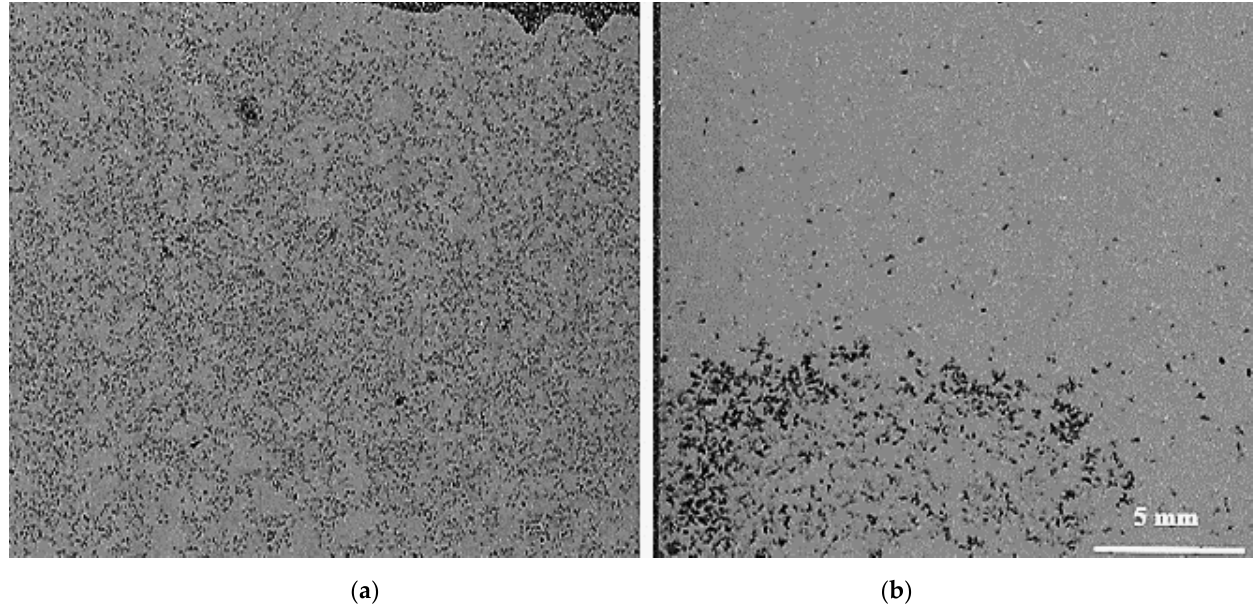
Figure 4. ( a ) Uniform distribution of Al 3 Ti particles with continuous mechanical stirring, ( b ) Sedi- mentation of Al 3 Ti particles to the bottom of the crucible with no mechanical stirring.